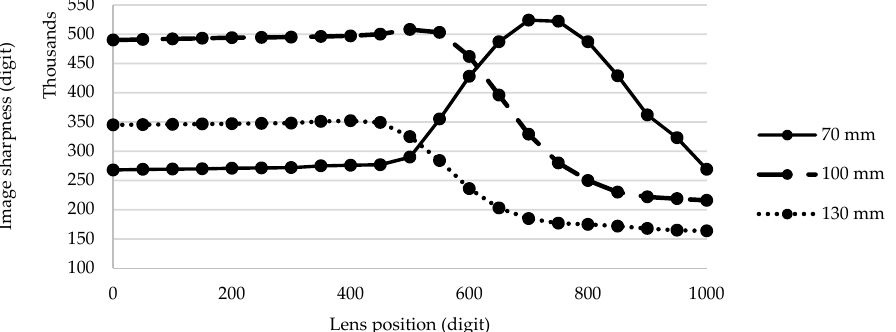
Figure 12. Measured image sharpness as a function of distance from the object.